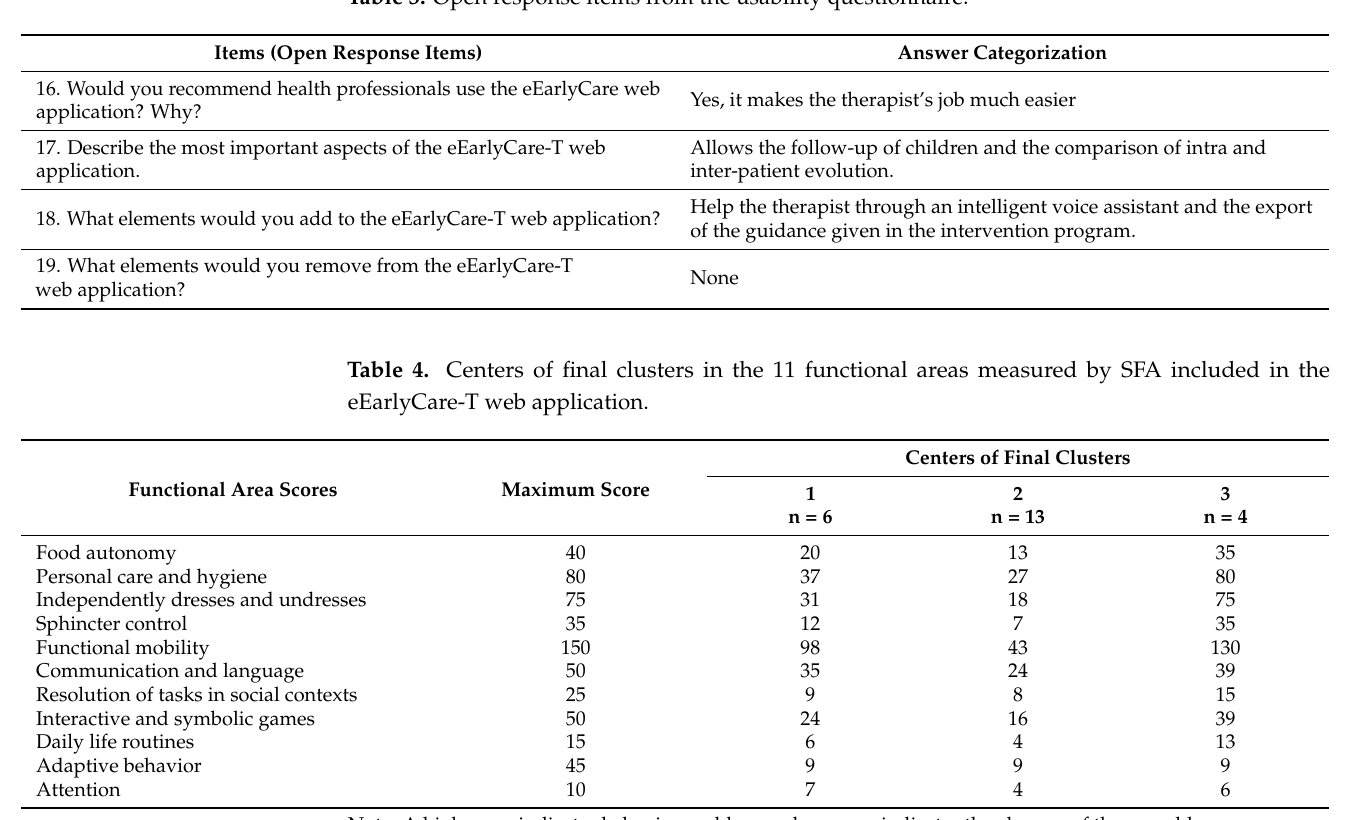
Table 3. Open response items from the usability questionnaire.